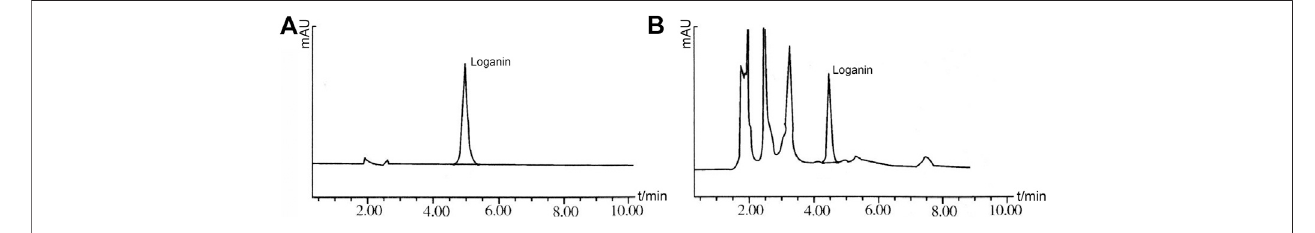
FIGURE 2 | The results of HPLC. (A) : Loganin solution; (B) : ZBDHD